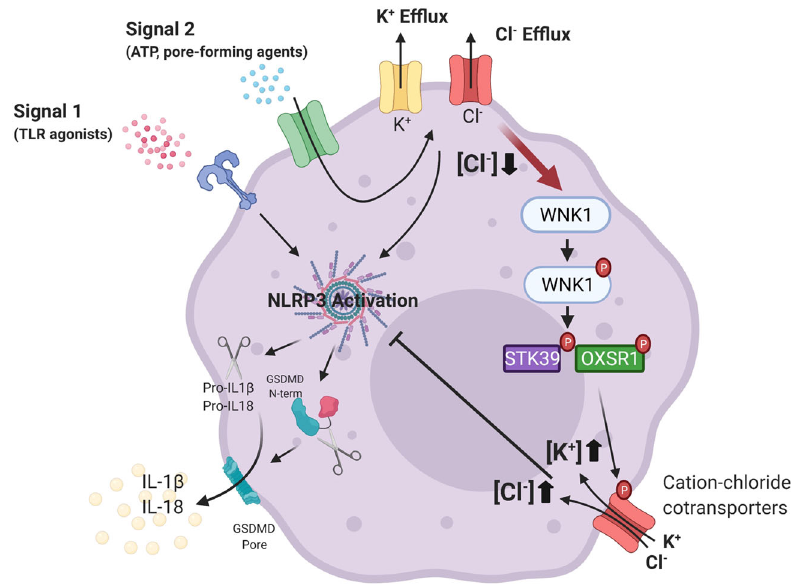
Fig. 10 Model for regulation of NLRP3 activation and pyroptosis by WNK1 signaling. Following the NLRP3 in fl ammasome priming step (signal 1), NLRP3 activating stimuli (signal 2) induce K + and Cl − ef fl ux from the cell which trigger NLRP3 in fl ammasome assembly. WNK1 senses the resulting decrease in intracellular Cl − and becomes autophosphorylated. WNK1 proceeds to phosphorylate its downstream targets STK39/OXSR1, which activate cation-Cl − cotransporters to restore ion concentrations as well as inhibit further Cl − ef fl ux. Restoration of normal intracellular Cl − concentration inhibits further NLRP3 in fl ammasome activation and pyroptosis. (Created with